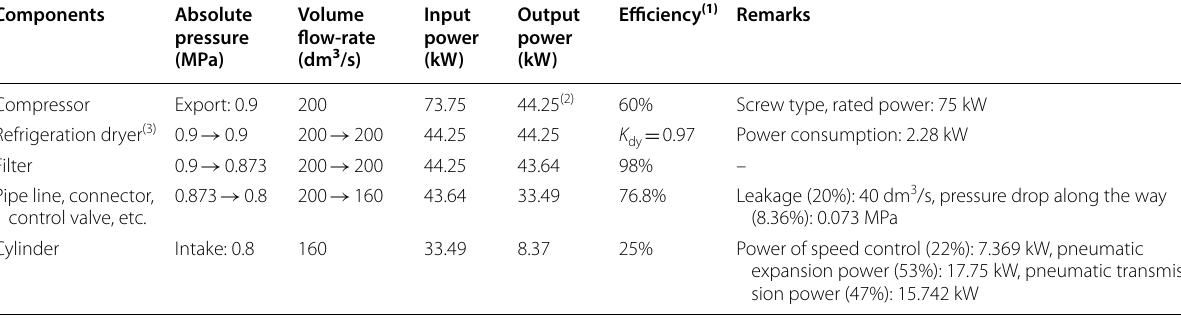
Table 7 Analysis of energy flow in a pneumatic